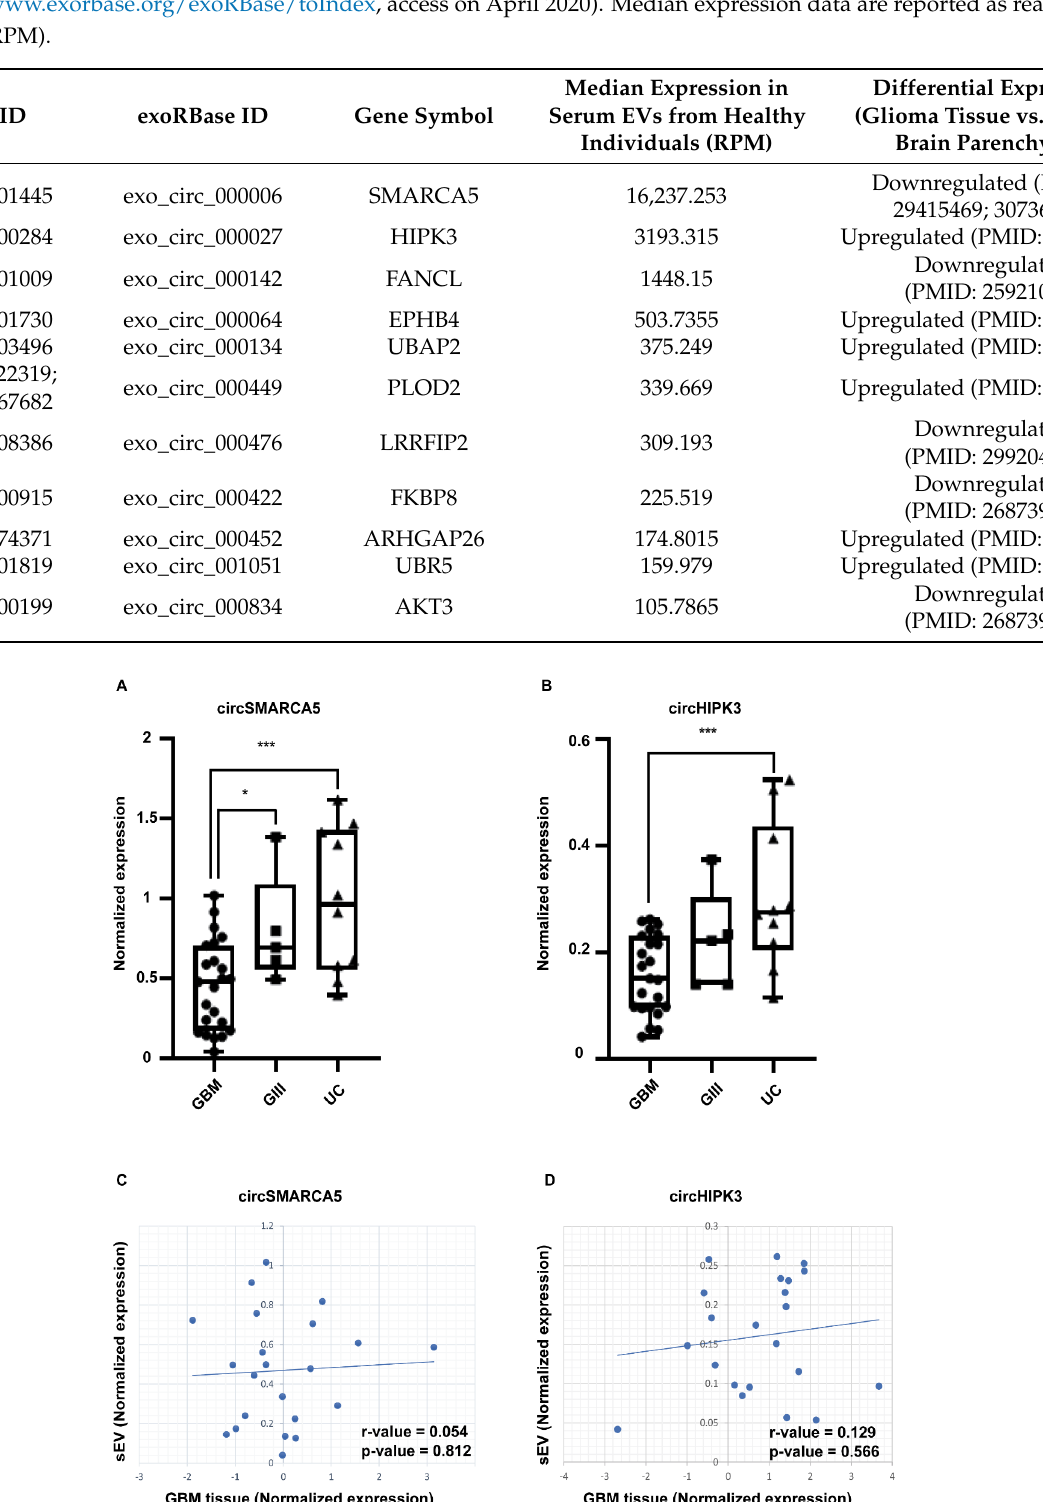
Figure 2. CircSMARCA5 ( A ) and circHIPK3 ( B ) expression in sEVs isolated from GBM, GIII and UC. Data are represented as box and whisker plots of normalized ddPCR data. * p -value < 0.05; *** p -value < 0.001, Student’s t -test (n GBM = 23; n GIII = 5; n UC = 10). Correlation between the expression of sEV-derived and GBM tissue-derived circSMARCA5 ( C ) and circHIPK3 ( D ) is reported as a dot plot. R-values were calculated through Pearson’s correlation test; p -values were calculated according to r-values and the number of clinical specimens